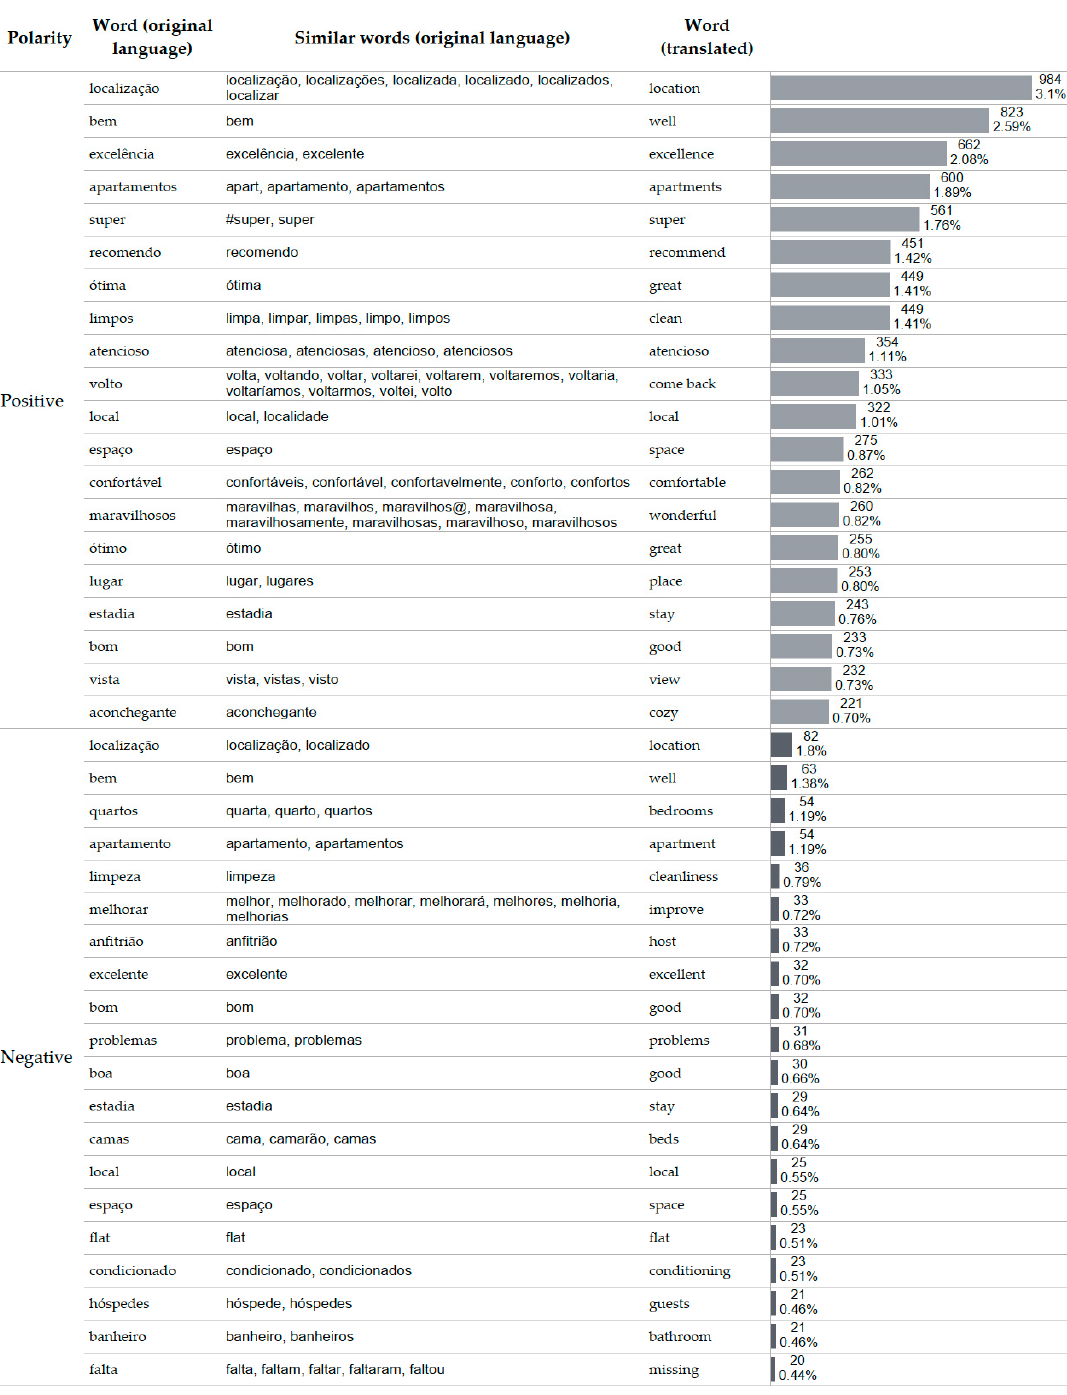
Figure 5. Most frequent words in positive and negative comments (top 20).